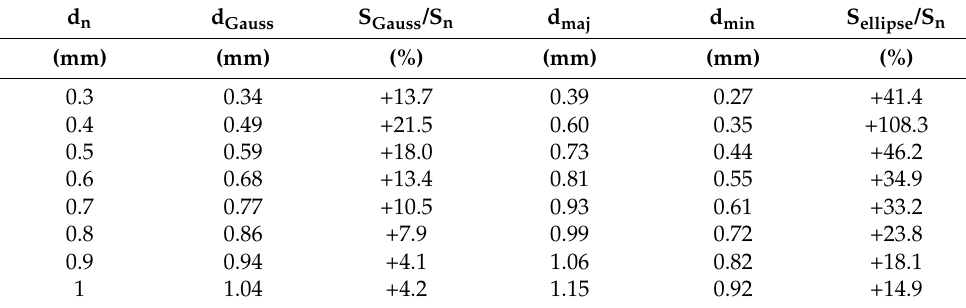
Table 2. Average strut dimensions according to different measurement methods.